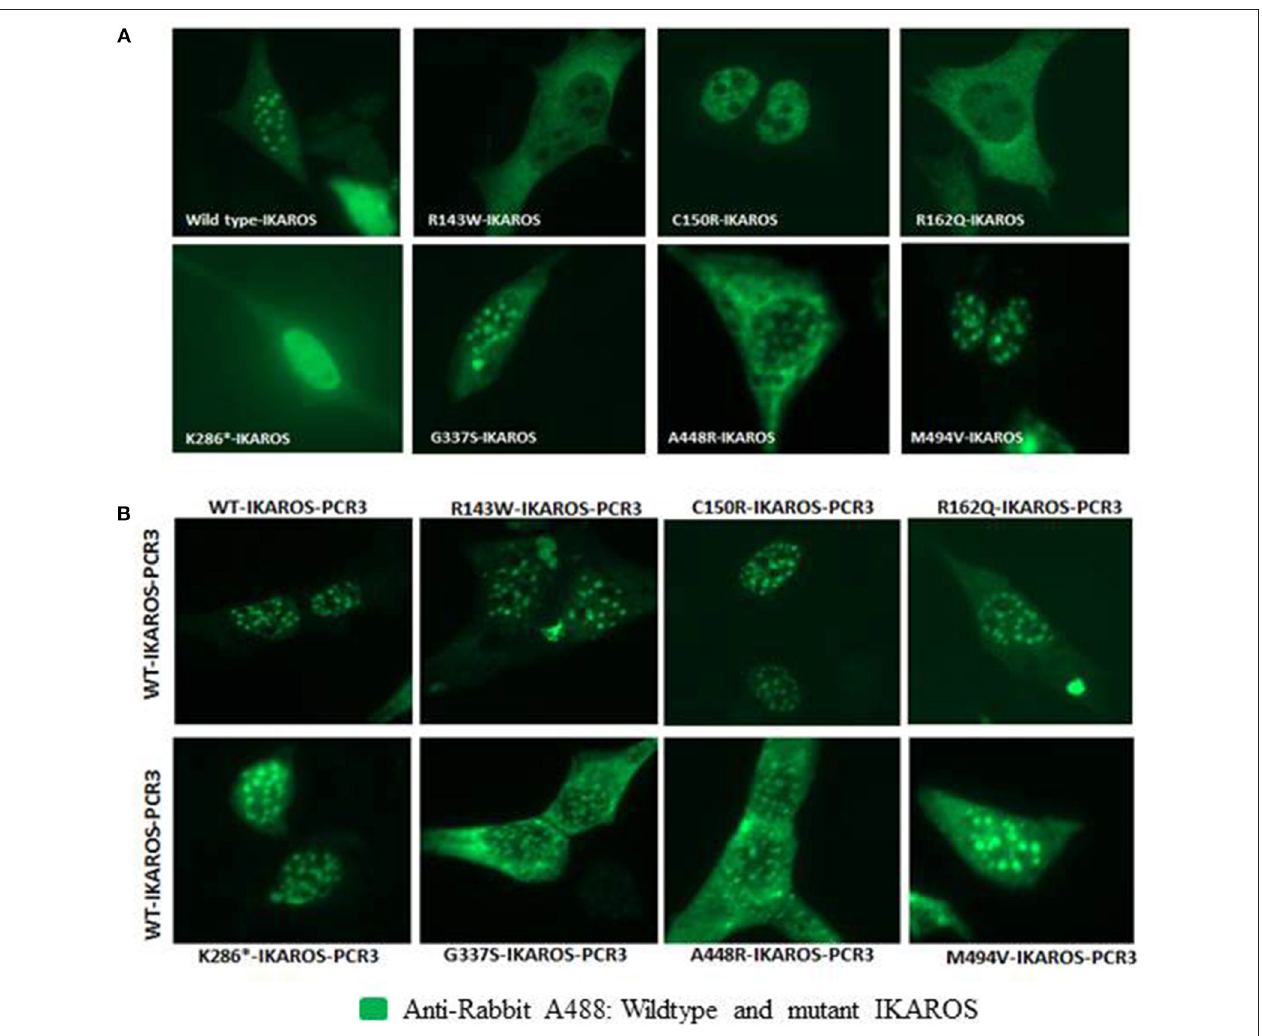
FIGURE 3 | IKAROS subnuclear and pericentromeric-heterochromatin localization. (A) NIH3T3 cells, transiently transfected with the pCR3 vector expressing wildtype or mutant IKAROS were incubated with rabbit-anti-human-IKAROS antibody and N-terminus anti-human IKAROS antibody and stained with goat anti-rabbit Alexa fluor 488. Cells overexpressing the wildtype IKAROS, showed the punctate staining pattern, observed in green. In contrast, a diffuse nuclear staining was observed in NIH3T3 cells overexpressing the Arg143Trp, Cys150Arg, Arg162Gln, and Lys286* mutant forms. (B) The DNA binding ability of wildtype IKAROS was not inhibited by the presence of a mutant variant. NIH3T3 cells were co-transfected with equal amounts of wild-type and each mutant pCR3 expression vectors and incubated and stained with the above-mentioned antibodies. In NIH3T3 cells co-transfected with equal amounts of wild-type and each mutant forms, the punctate nuclear staining pattern were obtained in all